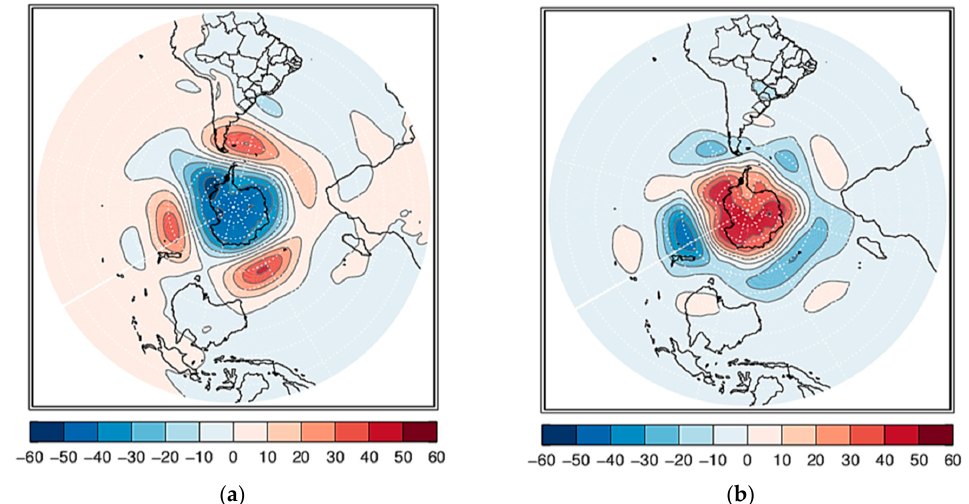
Figure 9. Composite of geopotential height anomalies (m) at 700 hPa during the beginning of SACZ events (lag = 0) in ( a ) AAO+ and ( b ) AAO–. events (lag = 0) in ( a ) AAO+ and ( b ) AAO −